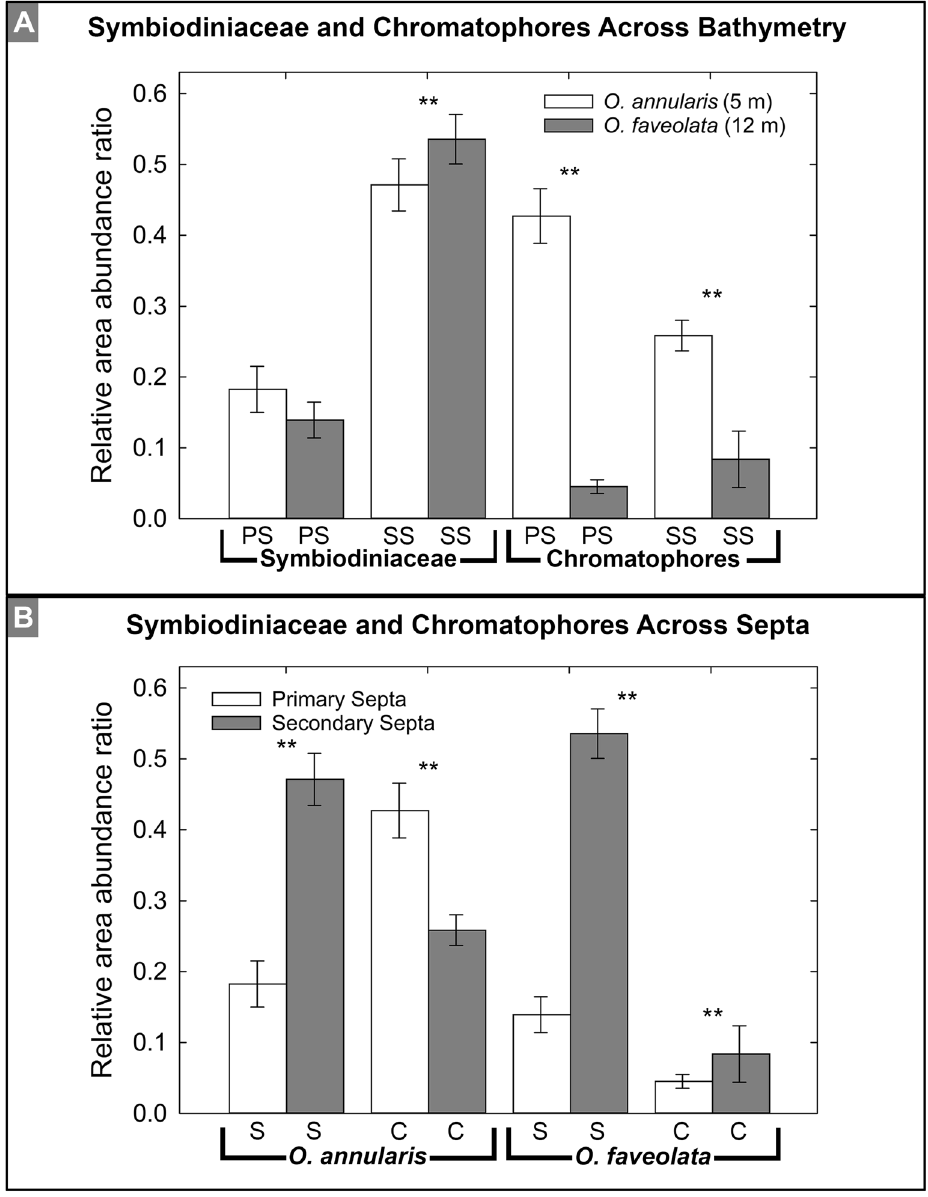
Figure 5. Abundance comparison of Symbiodiniaceae and chromatophores across bathymetry ( A ) and across septa ( B ) in O. annularis and O. faveolata. Mean values and standard error of normalized relative abundances are presented. Relative abundance shown on the y-axes are a ratio of the area occupied by the target cells divided by the total area in which cells were observed. There was no significant difference in the relative abundance of Symbiodiniaceae in tissues covering the primary septa, but was significant in the tissue overlying the secondary septa. Conversely, relative abundance of chromatophores in the tissues covering both the primary or secondary septa in O. annularis was significantly higher that those in O. faveolata and all other comparisons between them are significantly different (** = P 0.00476) based on the conservative Kruskal-Wallis statistical test. Labels include: PS–primary septa; SS–secondary septa; S–Symbiodiniaceae; and C–chromatopheres. Modified from Miller (2014) 58